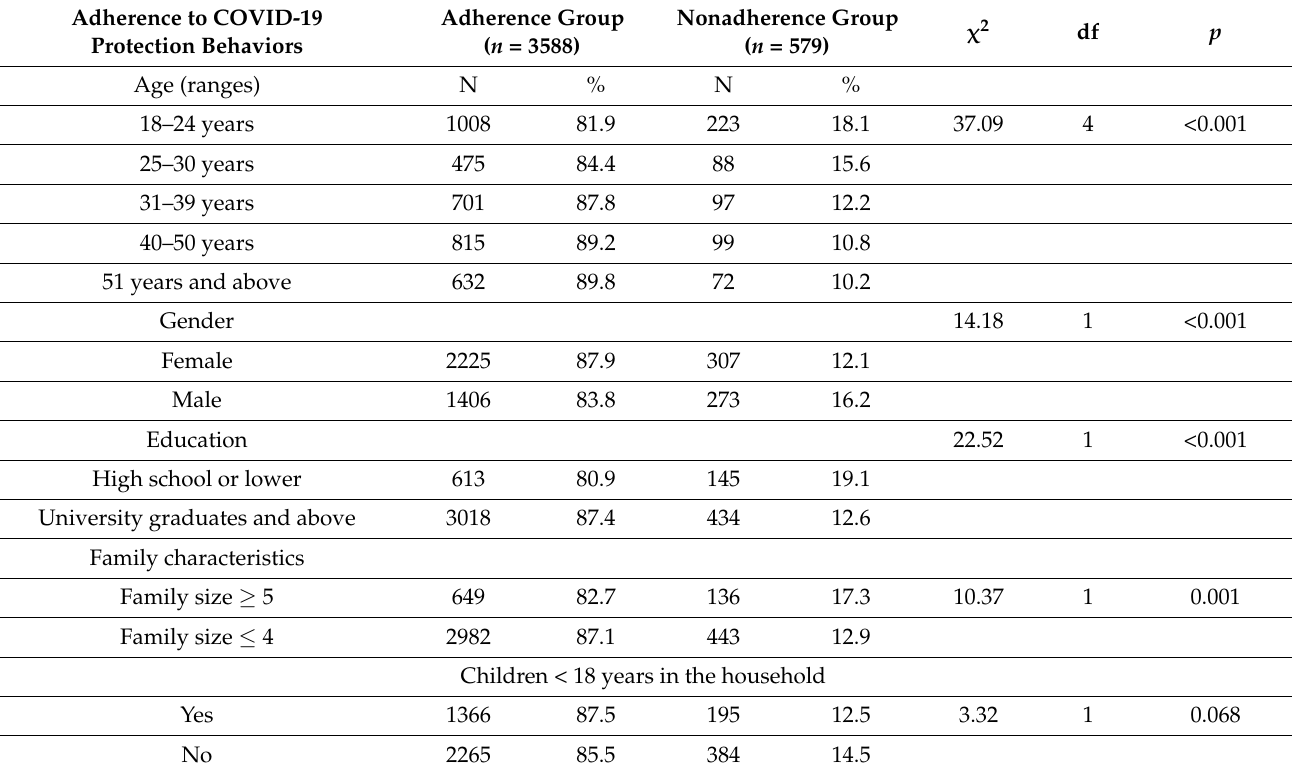
Table 1. Adherence to COVID-19 protection behaviors according to sociodemographic variables, knowledge, and exposure to COVID-19